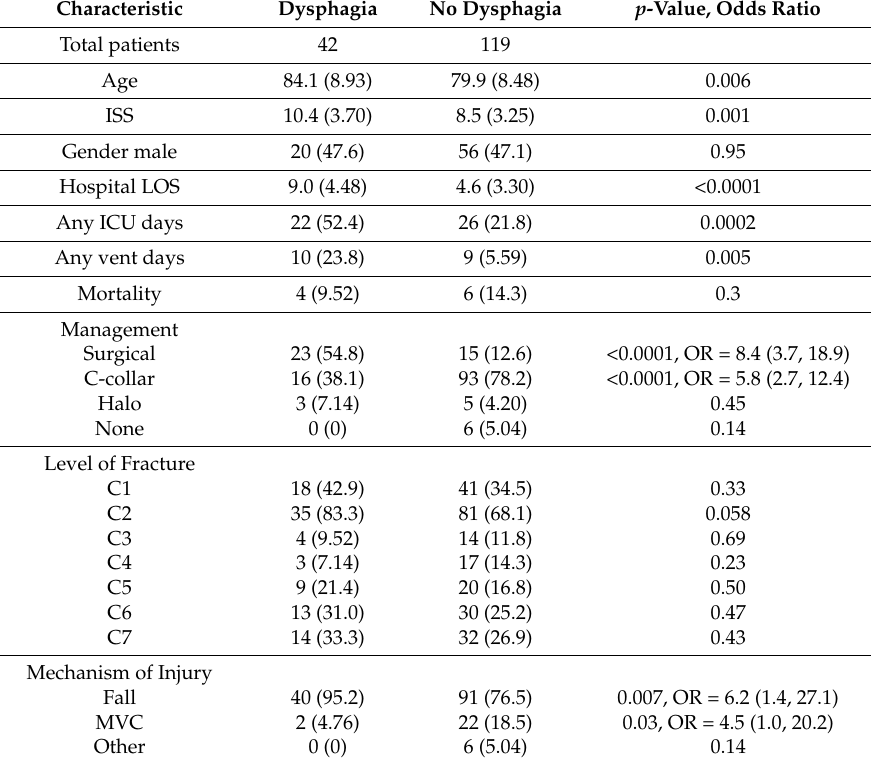
Table 2. Comparison of outcomes dysphagia vs. no